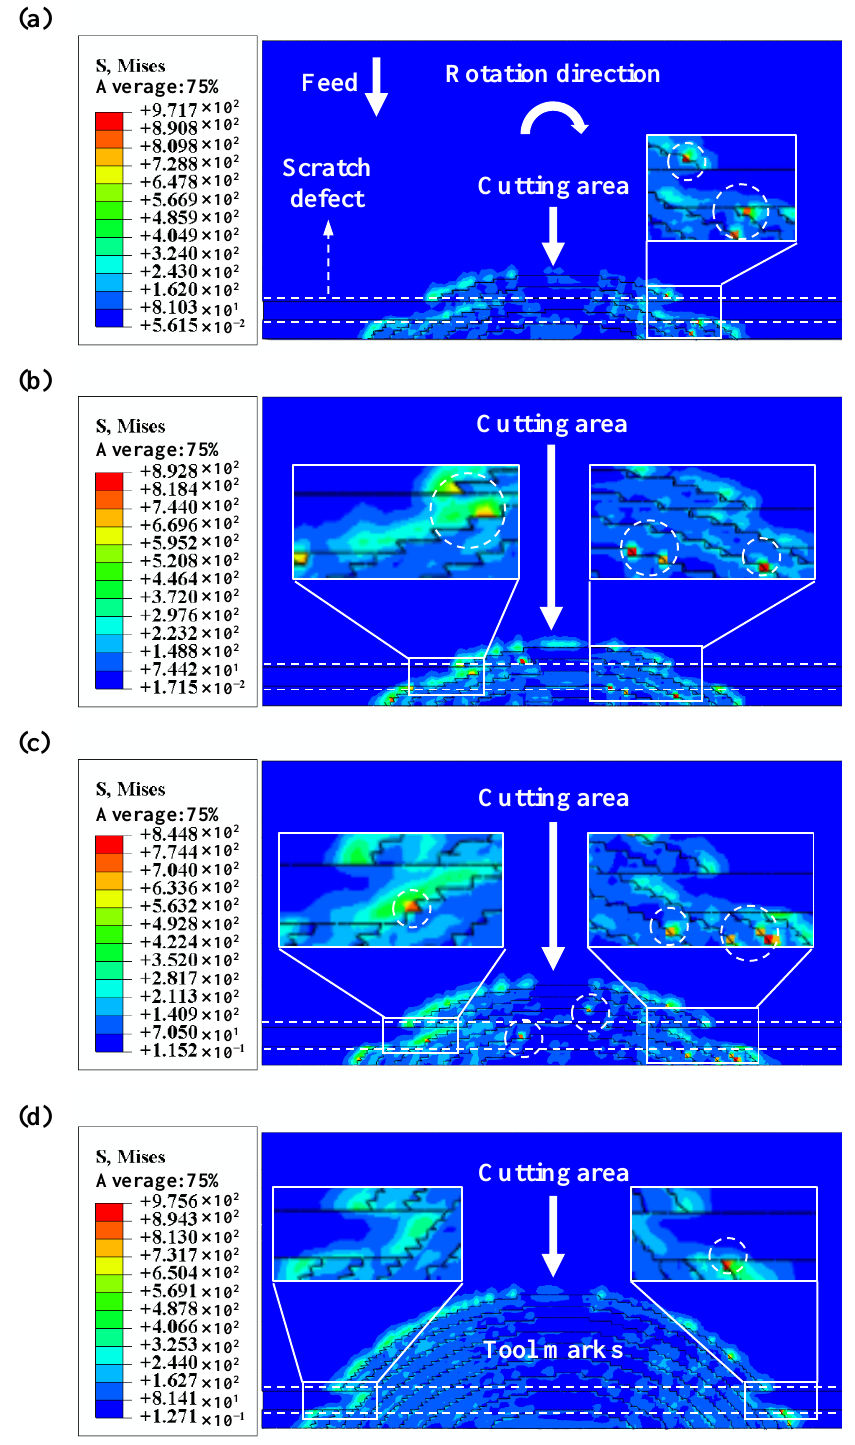
Figure 9. (Scratched surface) Simulated results of microgroove surface with different feed rates per tooth: ( a ) f t = 0.27 µ m/z, f t / r e = 0.15; ( b ) f t = 0.46 µ m/z, f t / r e = 0.25; ( c ) f t = 1.37 µ m/z, f t / r e = 0.75; ( d ) f t = 5.46 µ m/z, f t / r e = 3.0.